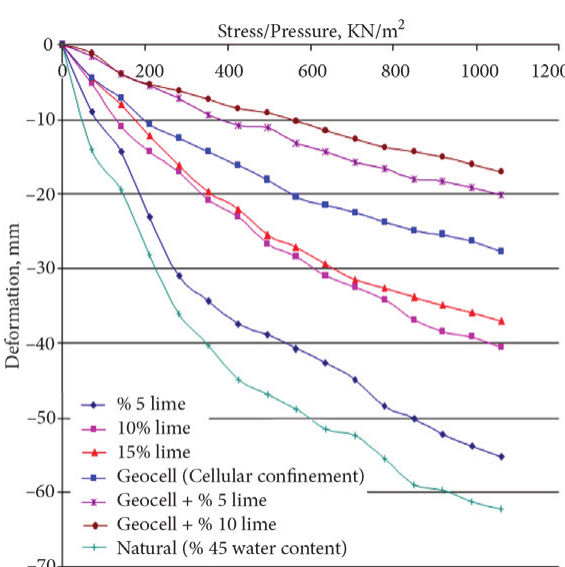
Figure 7. Load-deformation